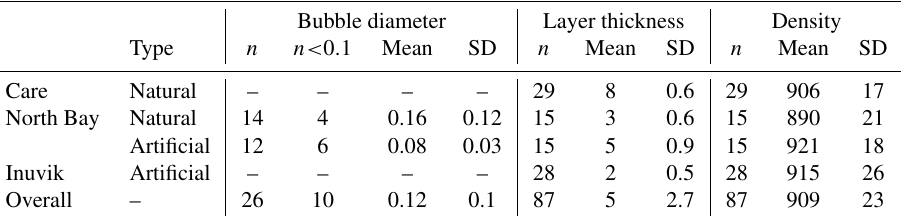
Table 1. Measurements of ice layer density bubble size and thickness (all sizes in millimetres, all densities in kgm − 3 ). n is number of samples, n < 0 . 1 is the number of samples with a bubble diameter of less than 0.1mm. All ice layer density values have been corrected to account for the measured − 0 . 19cm 3 bias in